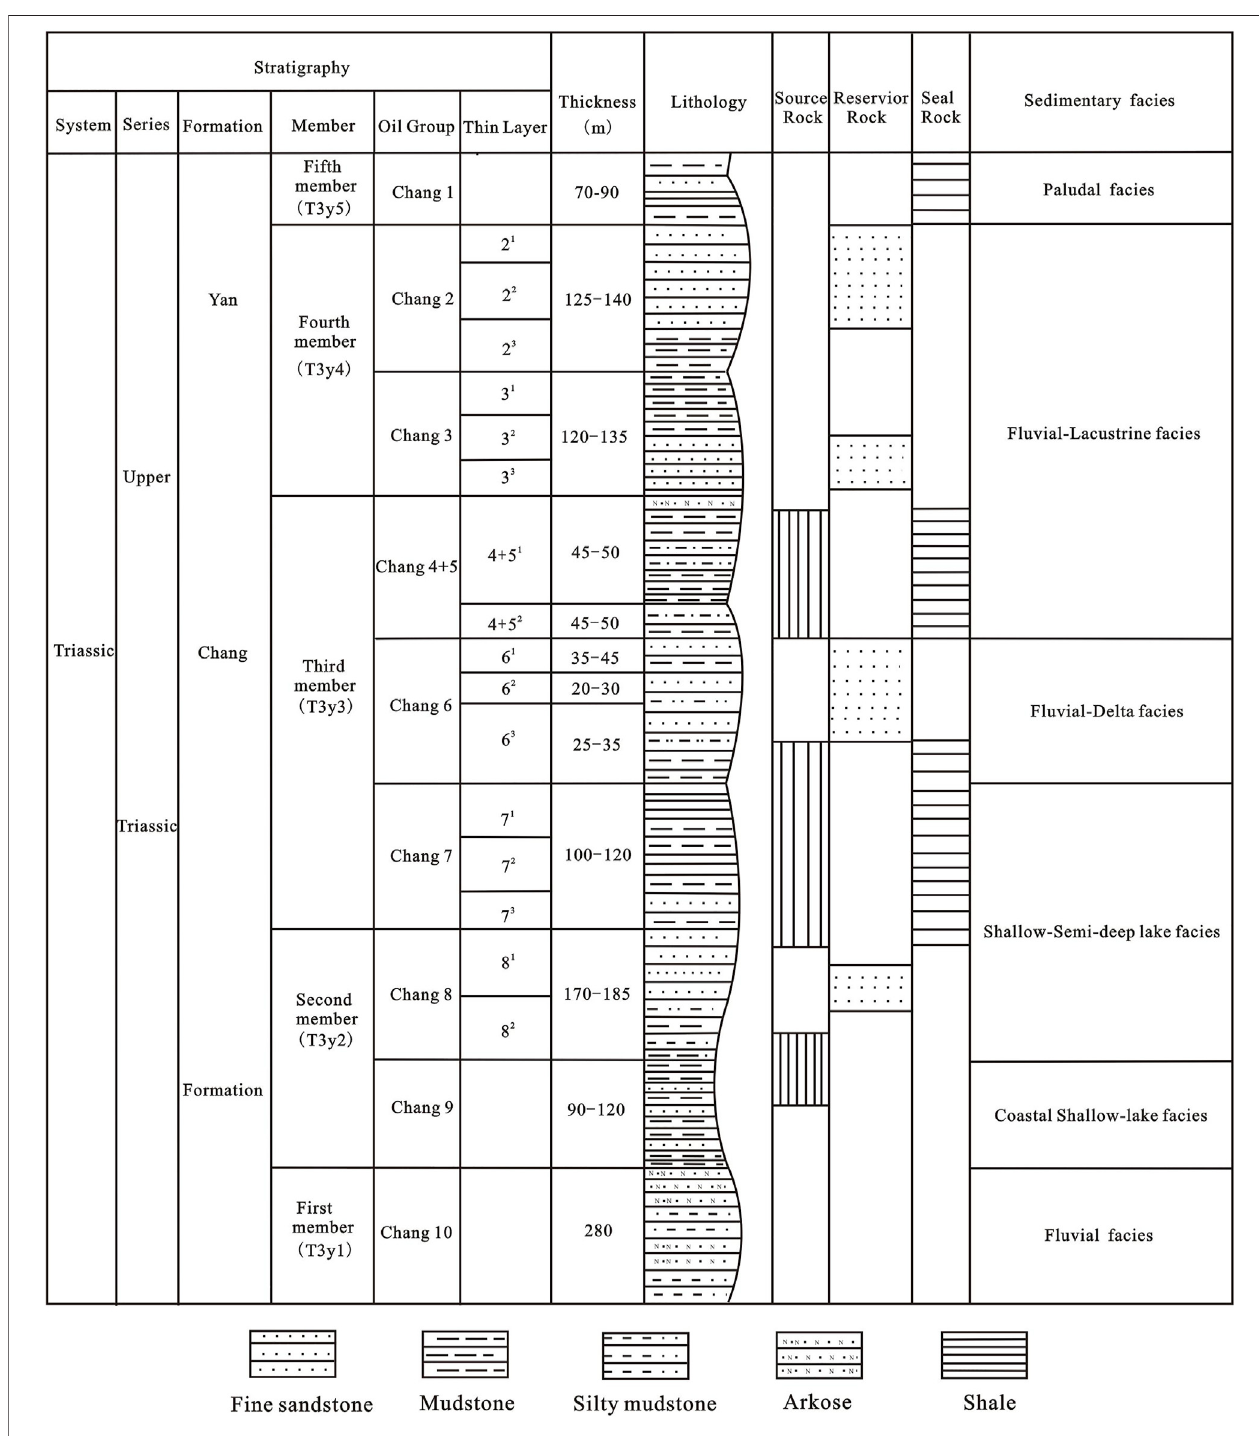
FIGURE2| StructuralcontourmapofthetopoftheChang8OilGroupoftheYanchangFormation(UpperTriassic),alongwiththeregionaldistributionofTriassicoil production areas and the location of the study area in the Ordos Basin (after Zhang et al., 2009).